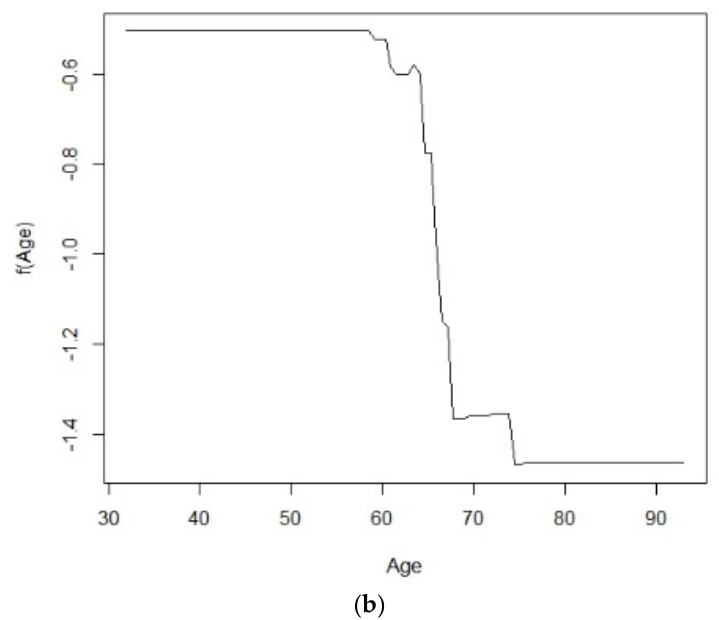
Figure 5. Partial dependence plots for the most influential variable for the two models; willingness to produce ( a ) and willingness to rent ( b ).